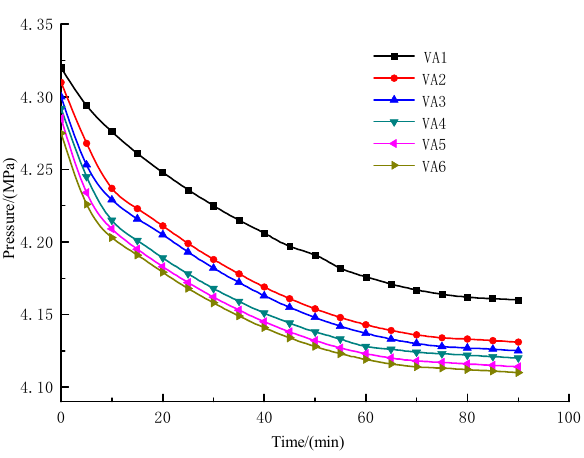
Figure 7. Hydrate formation process in the loop: ( a ) Clear gas-liquid two-phase flow; ( b ) Vague gas-liquid two-phase flow; ( c ) Particle hydrate slurry; ( d ) Cloud hydrate slurry.